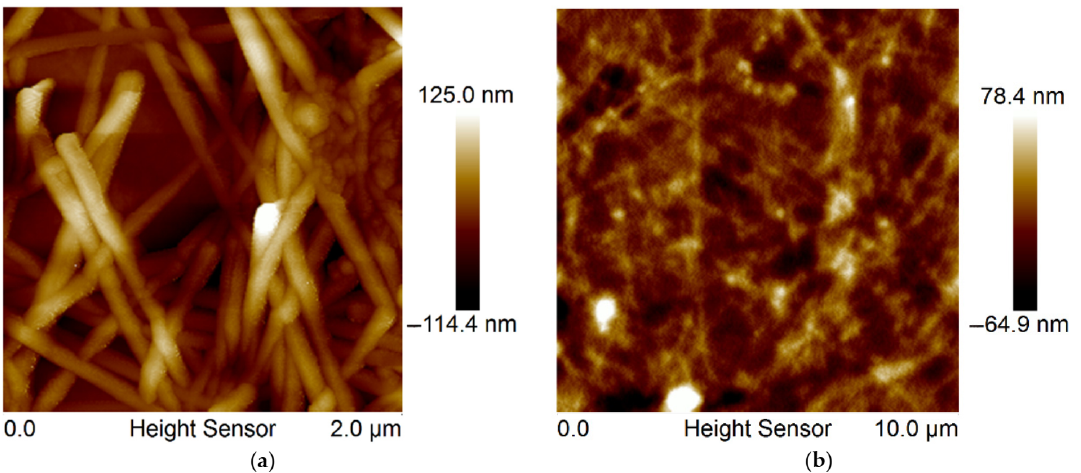
Figure 7. AFM image of AgNW conductive film: ( a ) before spin coating; ( b ) after spin